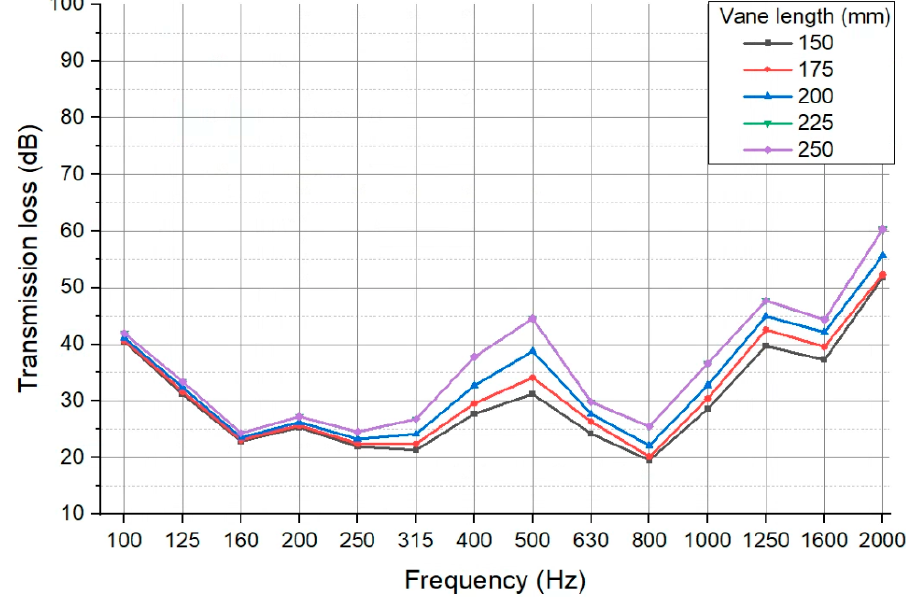
Figure 8. Transmission loss according to the vane length in the inner vane type.